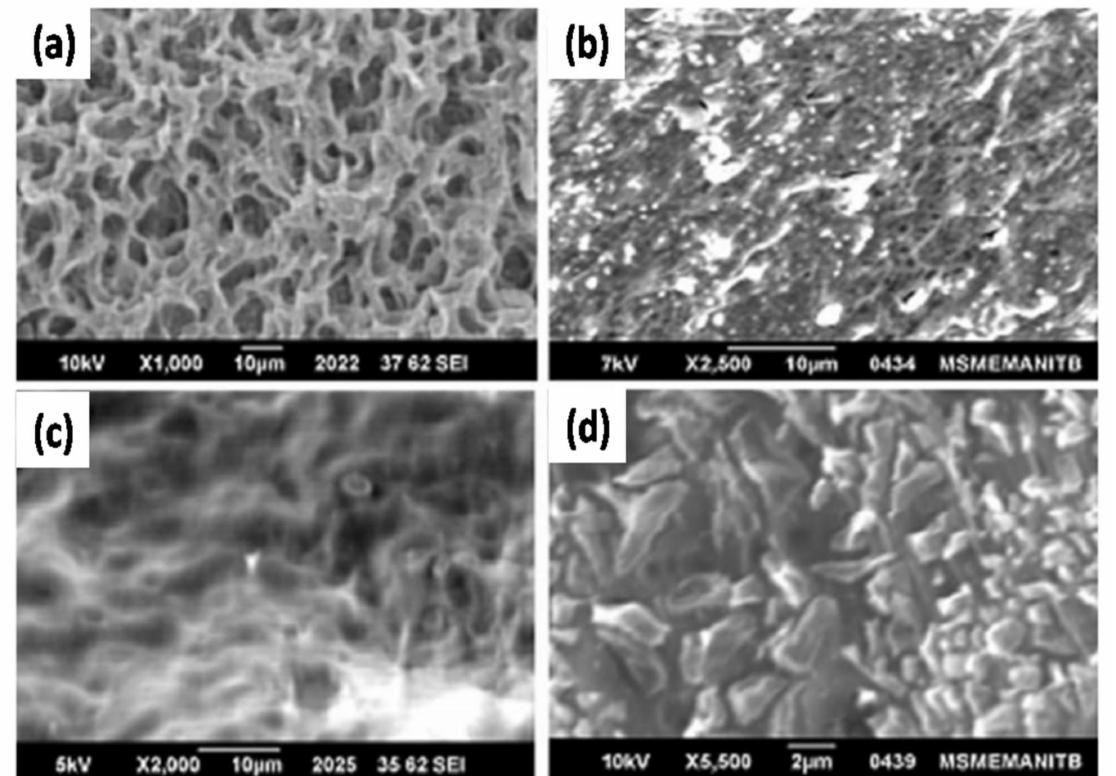
Figure 9. SEM images of the ( a ) PVA:NH 4 SCN/DMSO GPE containing ( b ) 2, ( c ) 6, and ( d ) 10 wt% Al 2 O 3 NPs. Reprinted with permission from Rat et al. [97]. Copyright 2012 Indian Academy of